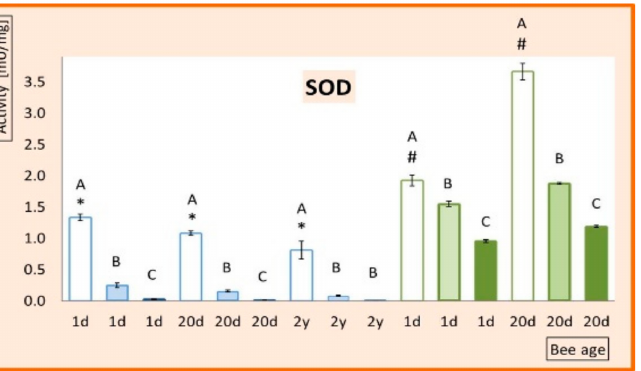
Figure 1. Mean activities of superoxide dismutase (SOD). The error bars indicate SD. Bee diet (group) contains 0 ppm (I-0), 5 ppm (I-5), and 200 ppm (I-200) imidacloprid. 1-day-old bees (1d), 20-day-old bees (20d), and 2-year-old bees (2y); queens ( blue bars ); workers ( green bars ); bee diet contains 0 ppm ( transparent bars ), 5 ppm (light-shadowed bars), and 200 ppm (dark-shadowed bars) of imidacloprid. Different capital letters indicate that differences between the means (diets) nested within a particular age and caste are significant (ANOVA + LSD; p < 0.01). Values marked with hash differ significantly from each other. Values marked with asterisk differ significantly from one